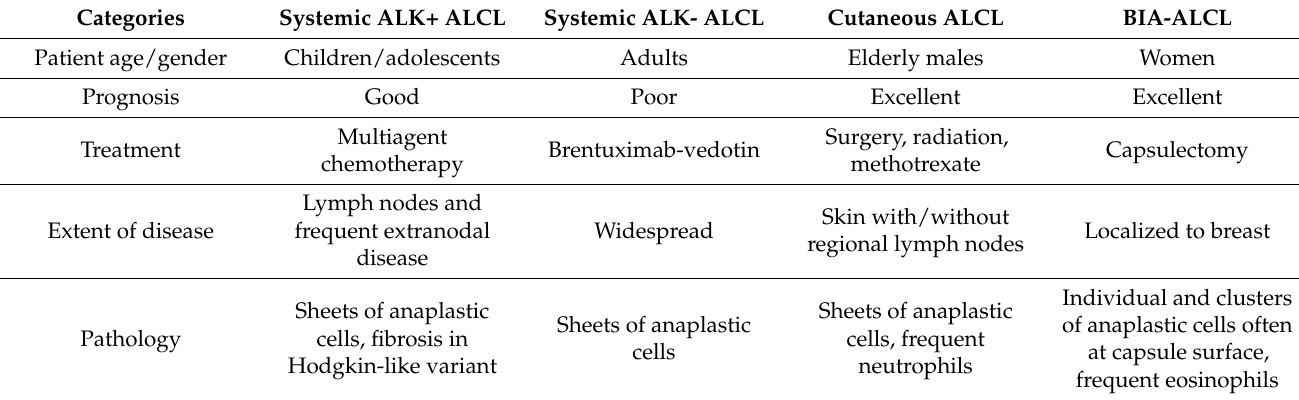
Table 1. Clinicopathological features of systemic, cutaneous and breast implant-associated anaplastic large cell lymphomas (systemic ALCL, C-ALCL, BIA-ALCL). ALK+ ALCL correspond to ALCL with anaplastic lymphoma kinase rearrangement.